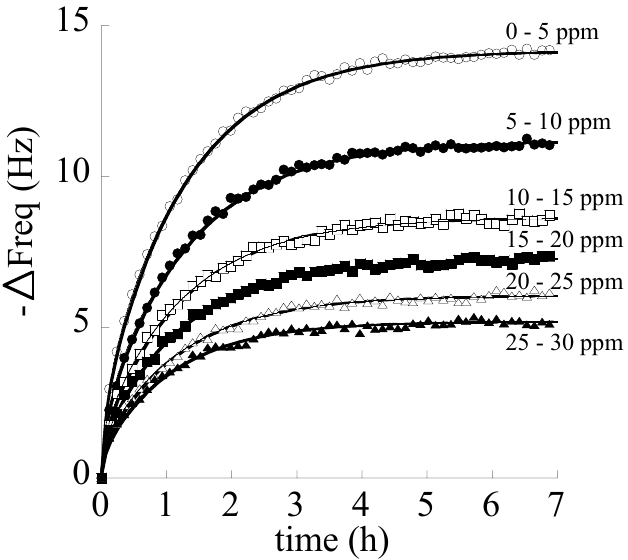
Figure 11. Change in frequency as a function of time in response to step changes in chloroform concentration. Solid lines represent fitting of data with Equation 4.